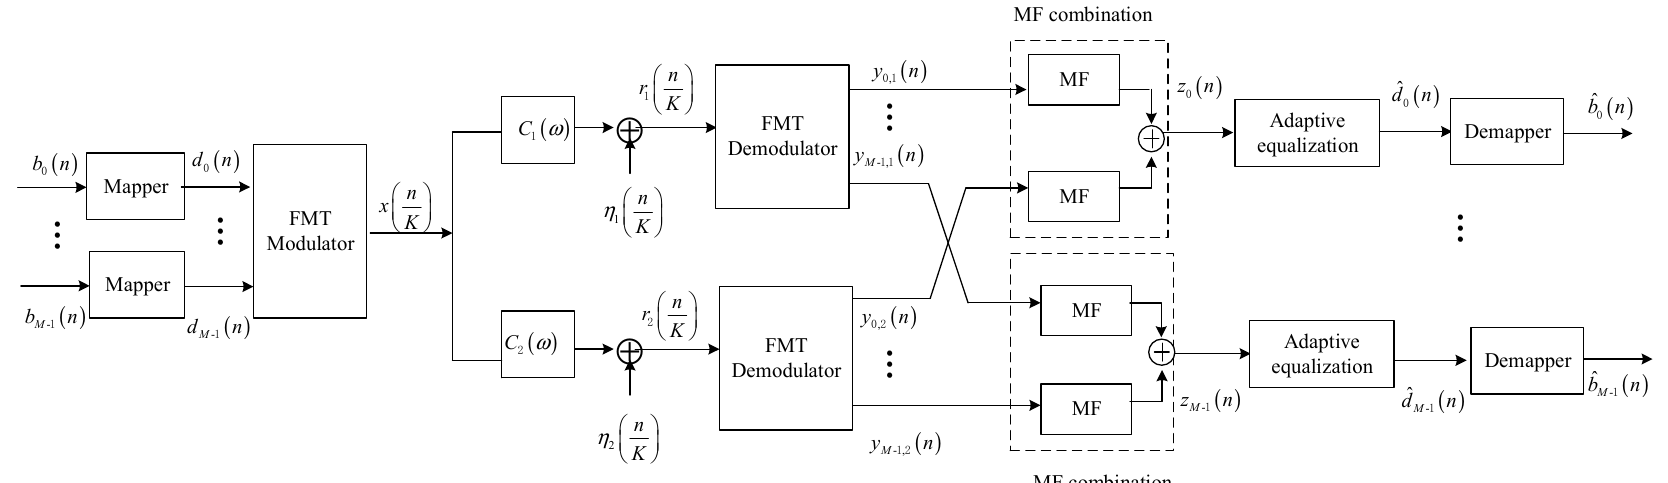
Figure 4. Block diagram for joint single-input–multiple-output (SIMO) and adaptive equalization.